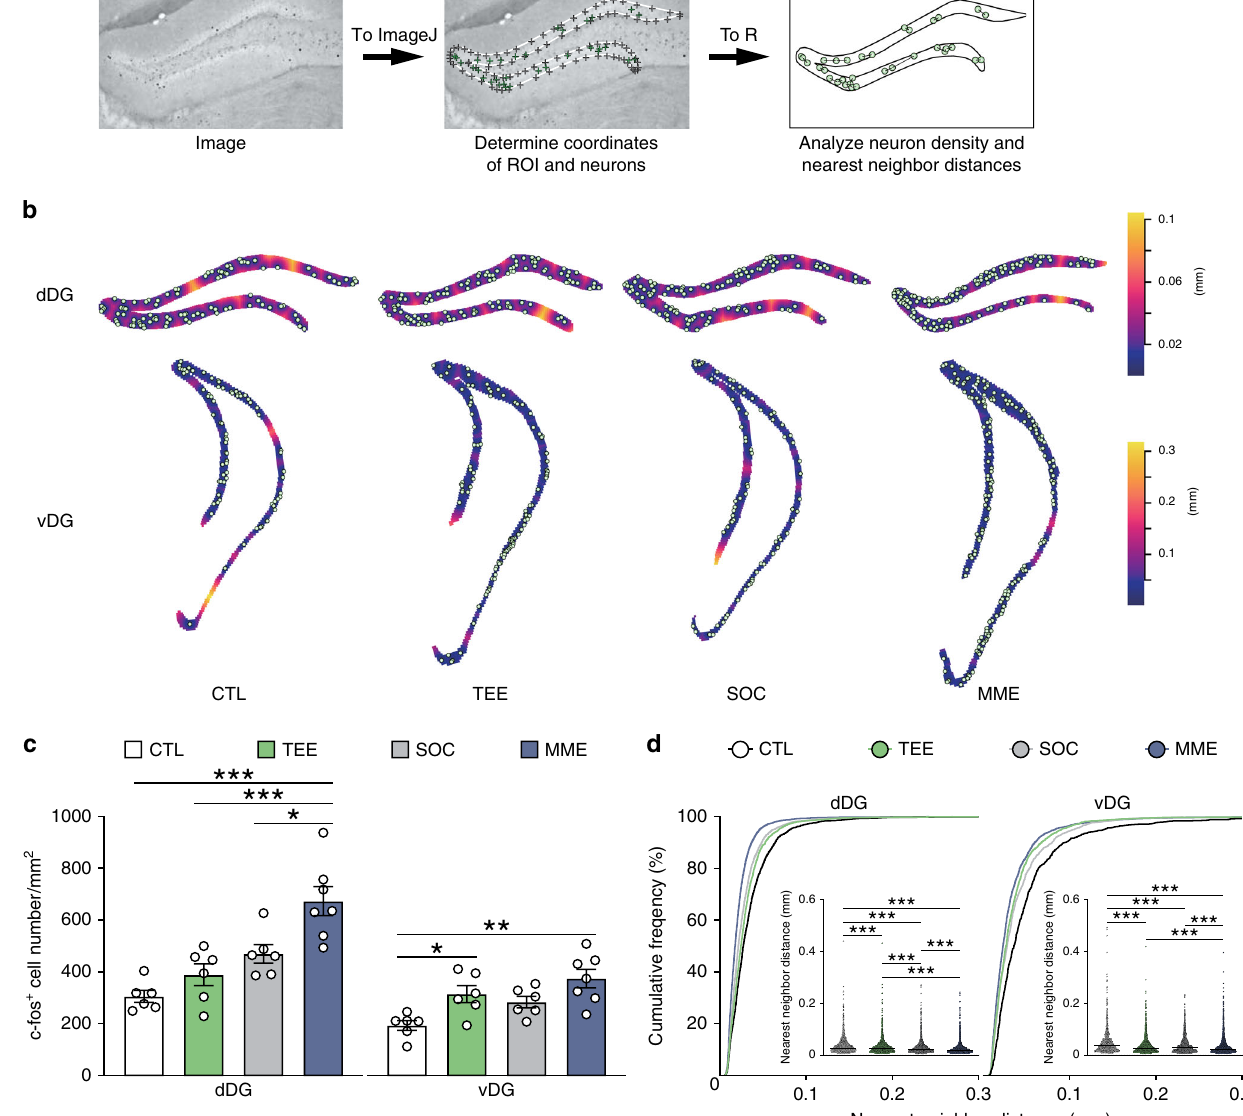
Fig. 2 Differential modulation of DG neuron activation by tactile enrichment and multimodal enrichment. a The pipeline for the density and spatial distribution pattern analysis of c-fos + neurons in DG. The image was imported to ImageJ to determine the coordinates of dentate granule cell layer (ROI, shown as gray crosses connected by a white line) and c-fos + neurons (green crosses). After importing the coordinates of ROI and neurons to R, the density and nearest neighbor distances (indicated by single- or double-headed arrows) of c-fos + neurons were analyzed by the spatstat package. b Representative plots of c-fos + neurons superimposed on empty space distance maps of dDG and vDG from the control (CTL, n = 6), TEE ( n = 6), social housing (SOC, n = 6), and MME ( n = 7) groups. c TEE for 10 days increased neuronal activation in vDG, while MME increased c-fos + neuron density in both dDG and vDG. d TEE, SOC and MME altered neuronal activation pattern in dDG and vDG. * P < 0.05, ** P < 0.01, *** P < 0.001. Data in bar charts are presented as mean ± SEM. Detailed statistics are provided in Supplementary Table 2. Source data are provided as a Source Data fi